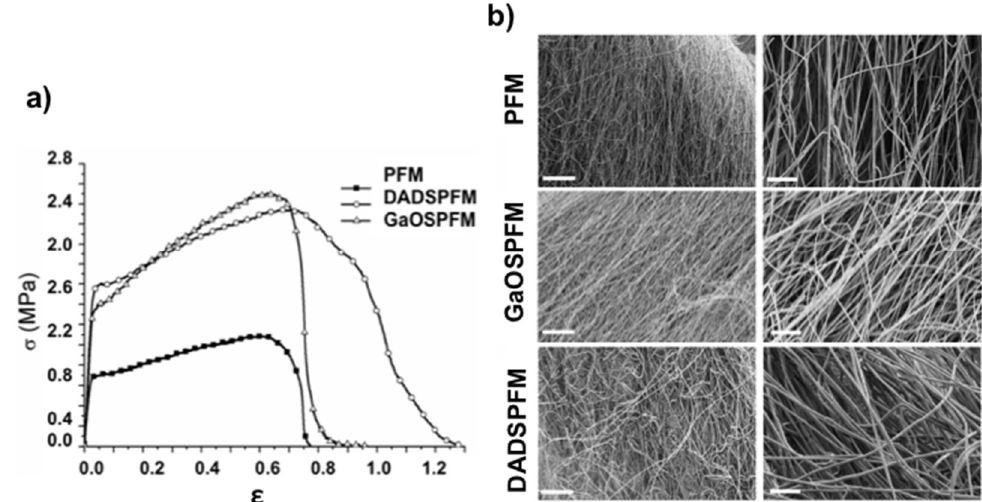
Figure 7. Mechanical properties of functionalized PFM. ( a ) Stress-strain curves of PFM, GaOSPFM, and DADSPFM; ( b ) SEM micrographs of the related fracture stress-strained surfaces (left: magnification 1k×, scale bar 50 μm, right: magnification 5k×, scale bar 10 μm).